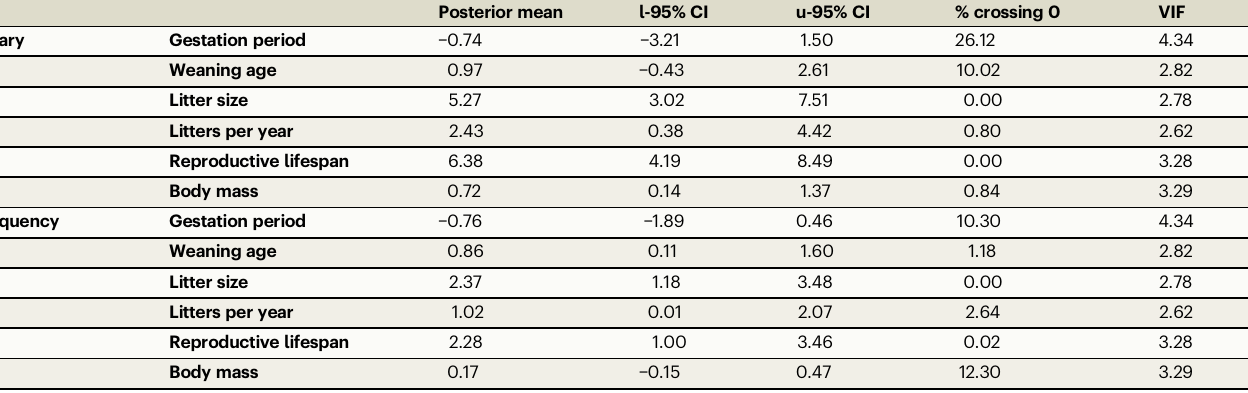
Table 2 | Life history predictors of US live wildlife trade probability and frequency in mammals from hurdle models Posterior mean l-95% CI u-95% CI % crossing 0 VIF −